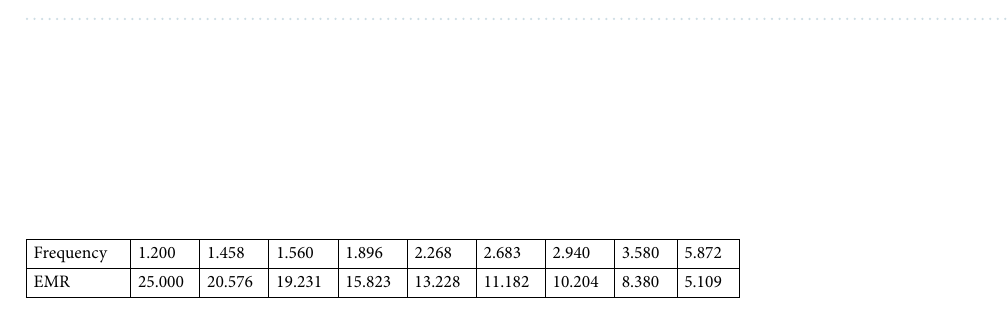
Figure 5. Absolute magnetic field distribution of the proposed MSM design at; (i) 1.2 GHz, (ii) 1.458 GHz, (iii) 1.56 GHz, (iv) 1.896 GHz, (v) 2.268 GHz, (vi) 2.683 GHz, (vii) 2.940 GHz, (viii) 3.580 GHz, (ix) 5.872 GHz.